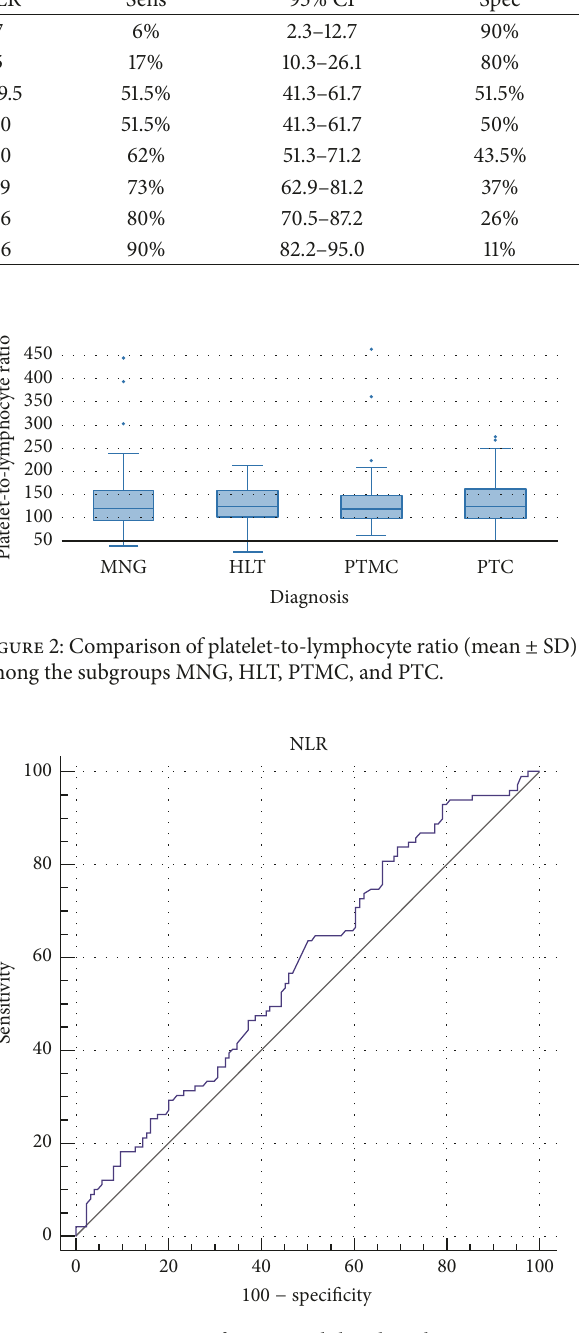
Figure 3: ROC curve for neutrophil-to-lymphocyte ratio.